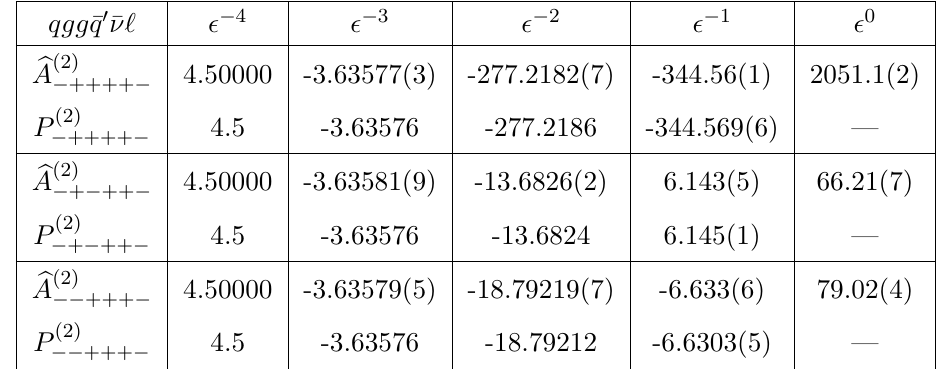
Table 5 . The numerical comparison of ^ A (2) (1 q ; 2 g ; 3 g ; 4 (cid:22) q 0 ; 5 (cid:22) (cid:23) ; 6 ‘ ) with the universal pole structure (2) de(cid:12)ned in eq. (3.6), using kinematic point of eq. (5.1), in the HV scheme. P